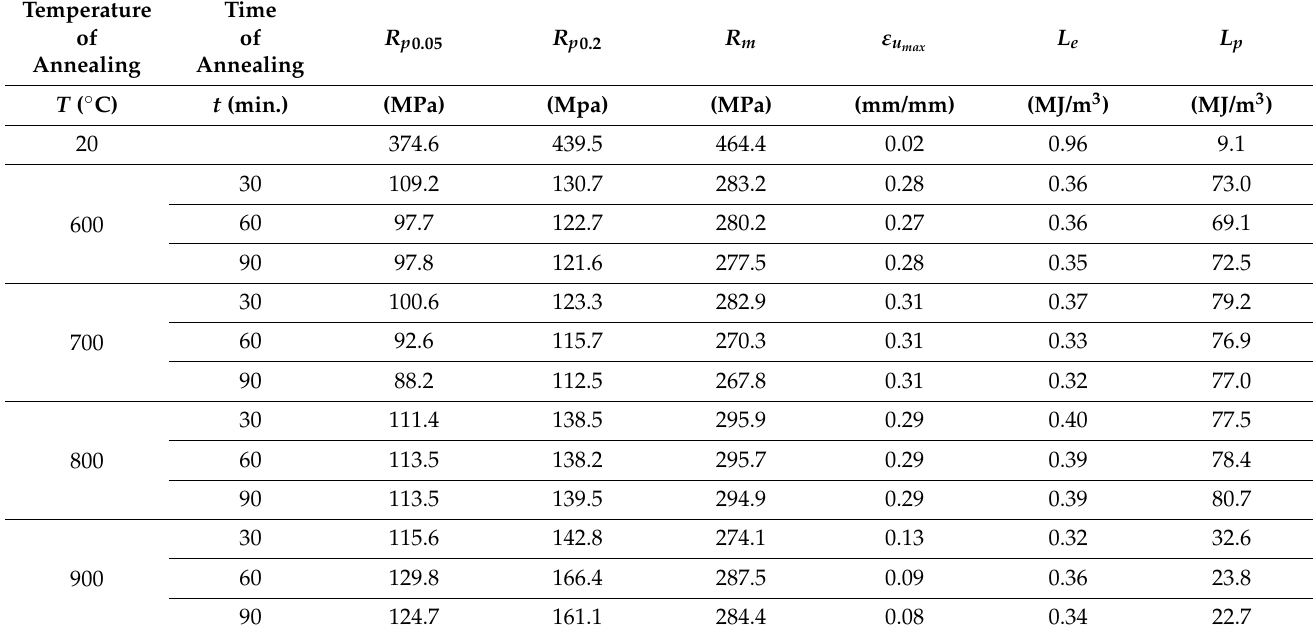
Table 3. The values of the mechanical properties of Ti/Cu bimetal obtained from tensile tests.